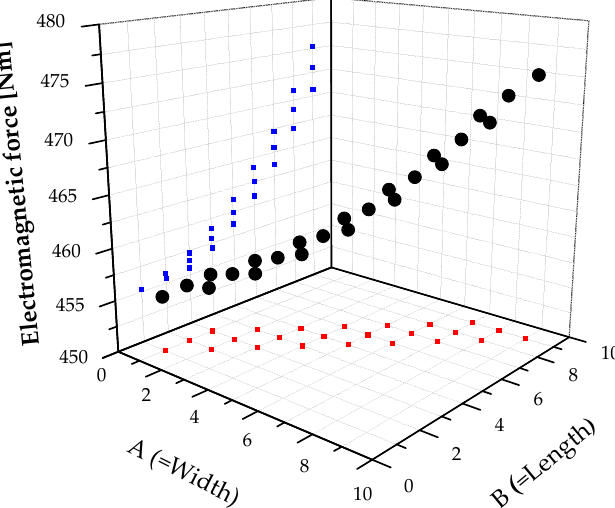
Figure 14. Schematic of variables A and B related to the corner shape of the lower core.